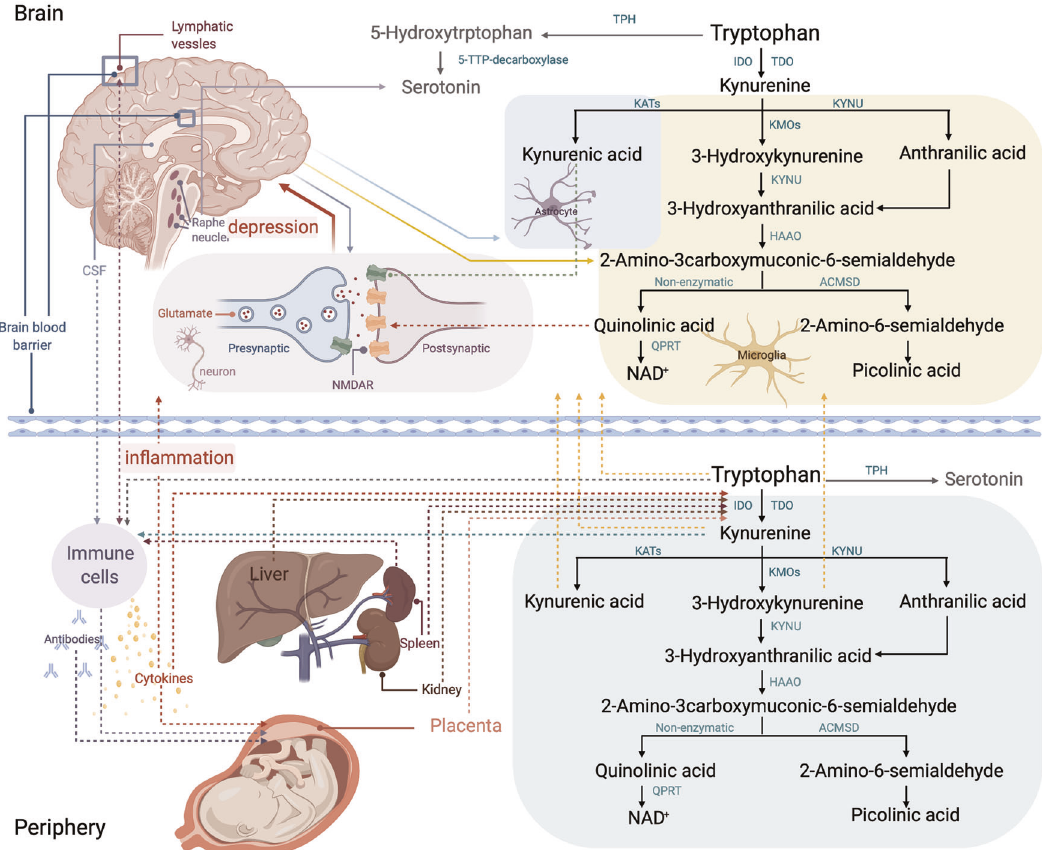
Fig. 1 Tryptophan metabolic pathways in the brain and periphery. Abbreviations: TPH tryptophan hydroxylase, IDO indoleamine 2,3- dioxygenase. TDO tryptophan 2,3-dioxygenase. KATs kynurenine aminotransferases. KYNU kynureninase, HAAO 3-hydroxyanthranilate 3,4- dioxygenase, ACMSD aminocarboxymuconate-semialdehyde decarboxylase, QPRT quinolinic acid phosphoribosyltransferase, CSF cerebrosp- inal fl uid, NMDAR N -methyl-D-aspartate receptor, NAD